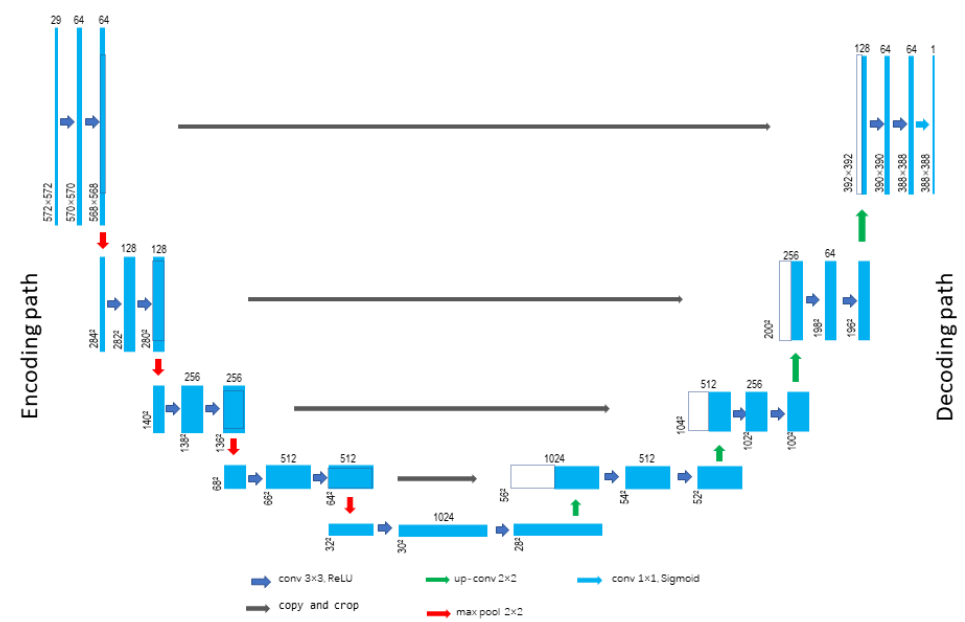
Figure 8. Traditional U-net model architecture [65] (example for 32 × 32 pixels in the lowest resolution and binary classification output).